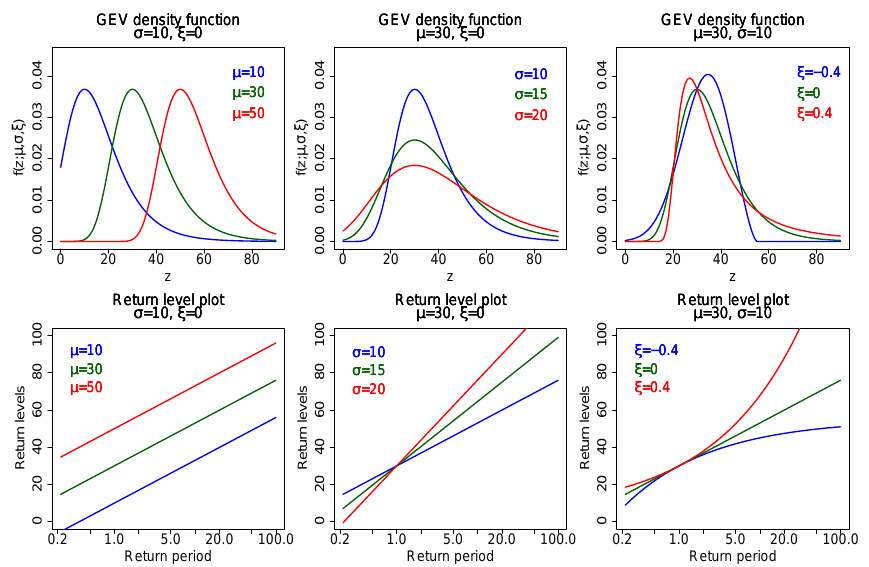
Fig. 1. Illustration of the GEV distribution. Upper panel: example of GEV densities f (x ; µ,σ,ξ) when varying the location µ parameter